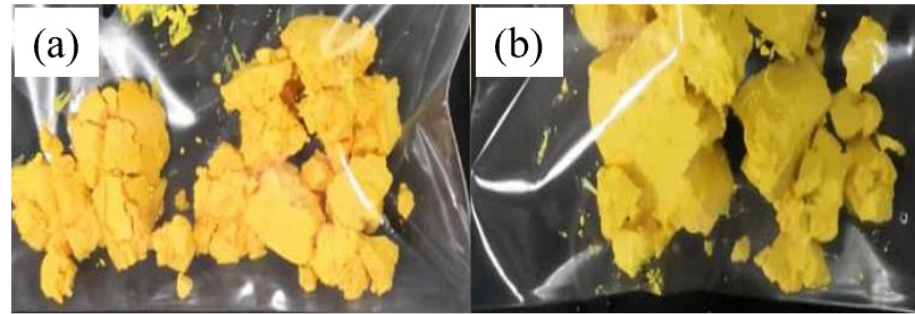
Figure 2. Picture of the precipitates: ( a ) precipitate-As(III); ( b ) precipitate-As(V).